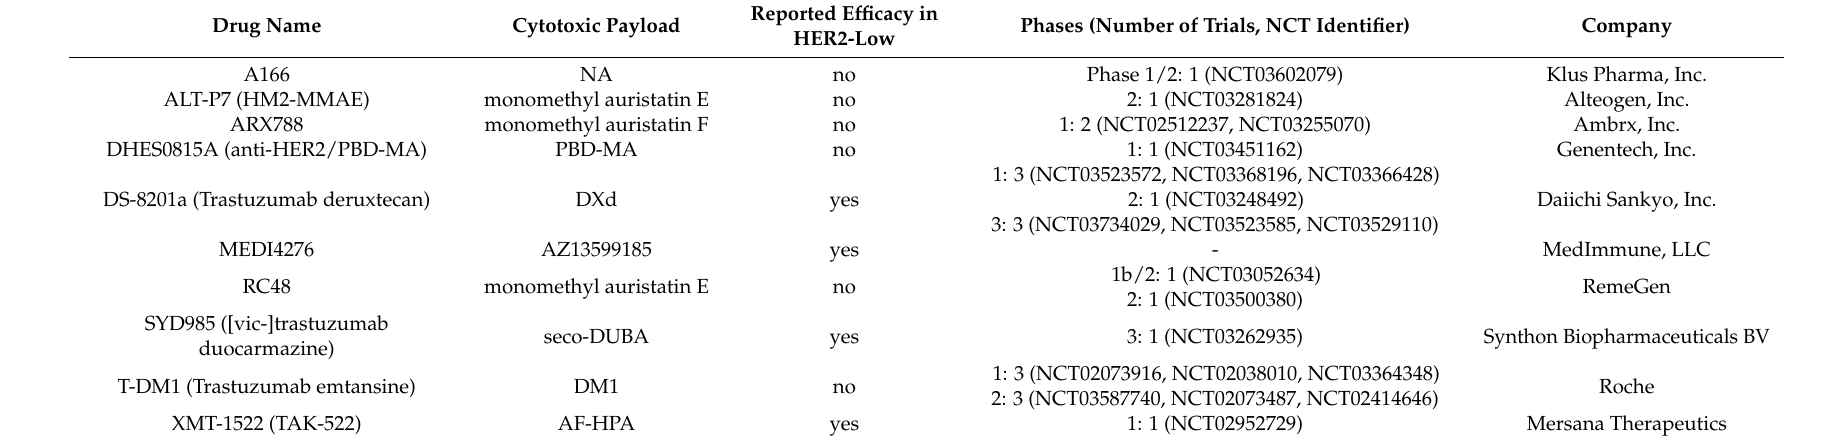
Table 1. Investigational HER2 targeting antibody drug conjugates in breast cancer.